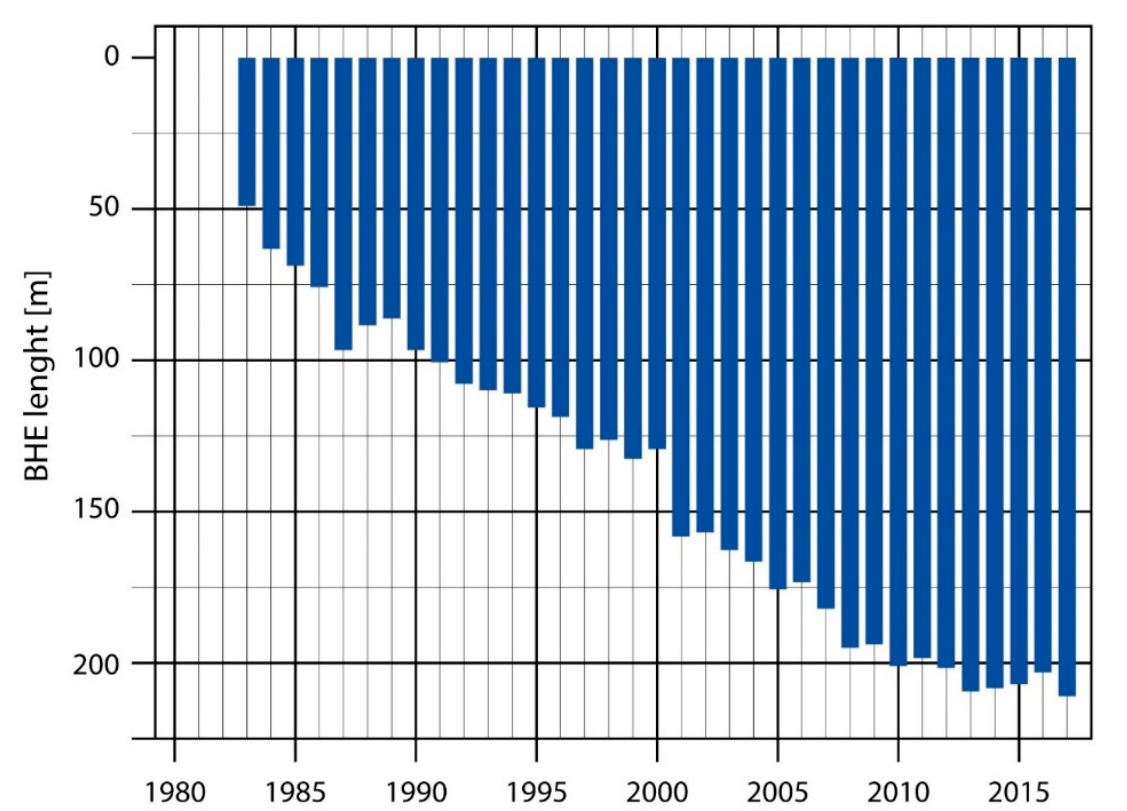
Figure 17. Average length of authorized BHEs in Canton Zurich. Data from [26] are plotted.